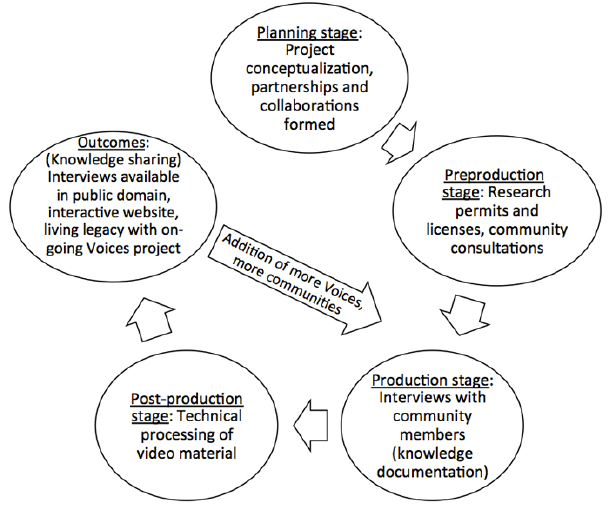
Fig. 1 . Process flow diagram for the Voices Project. Details of activities involved at each stage are provided in Table